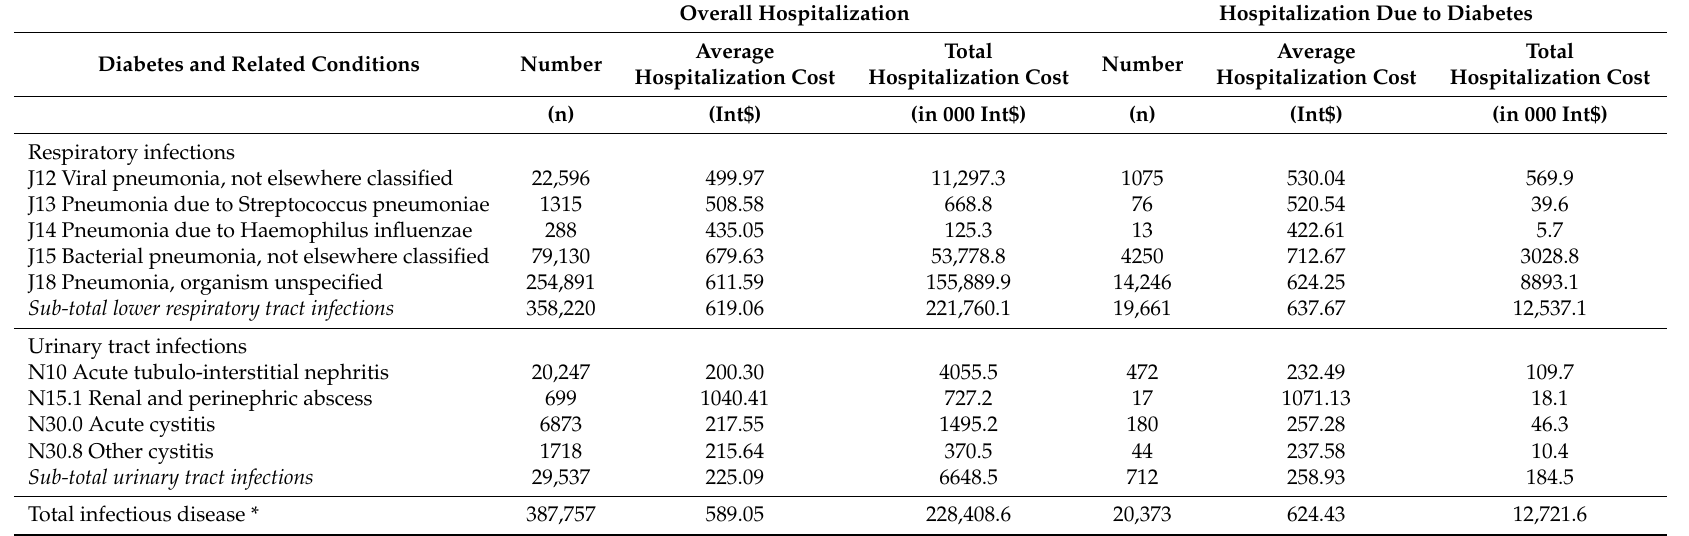
Table 7. Number, average and total hospitalization cost due to respiratory and urinary infectious diseases, overall and related to diabetes, adults (20+ years), SUS, Brazil